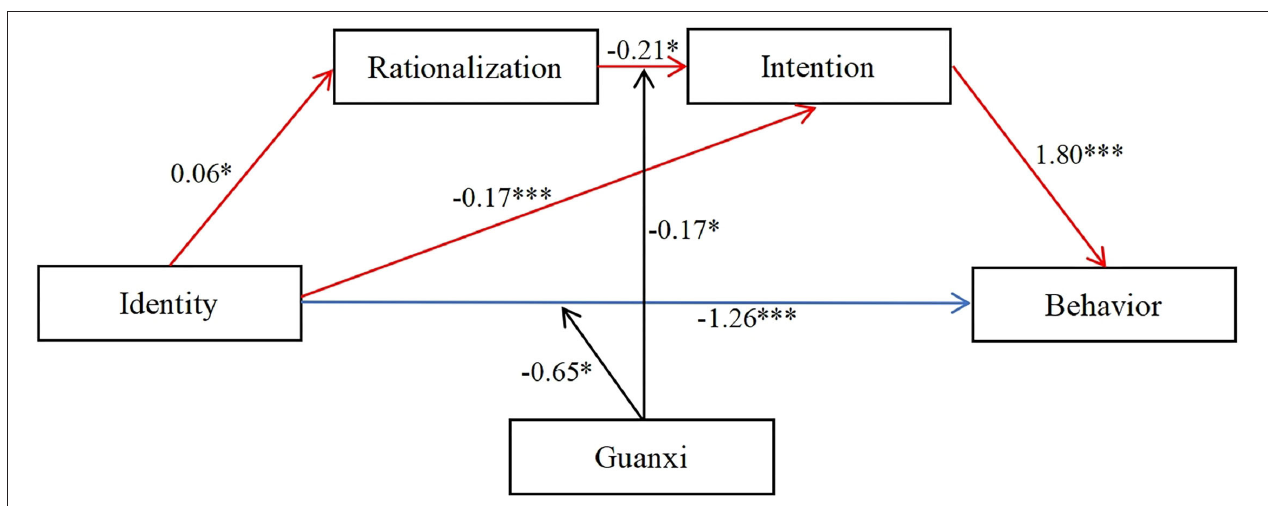
FIGURE 1 | The moderated serial multiple mediation model. * p < 0.05, ** p < 0.01, *** p < 0.001.